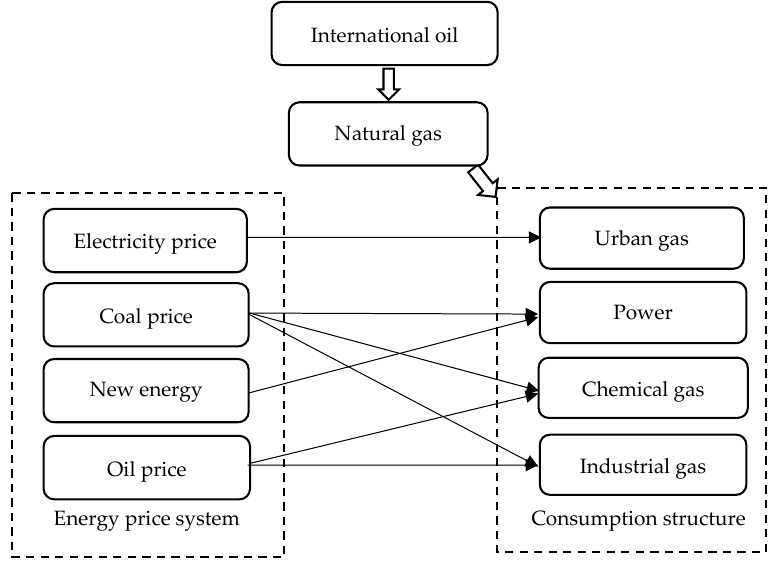
Figure 2. Mechanism of the influence of oil price on natural gas.